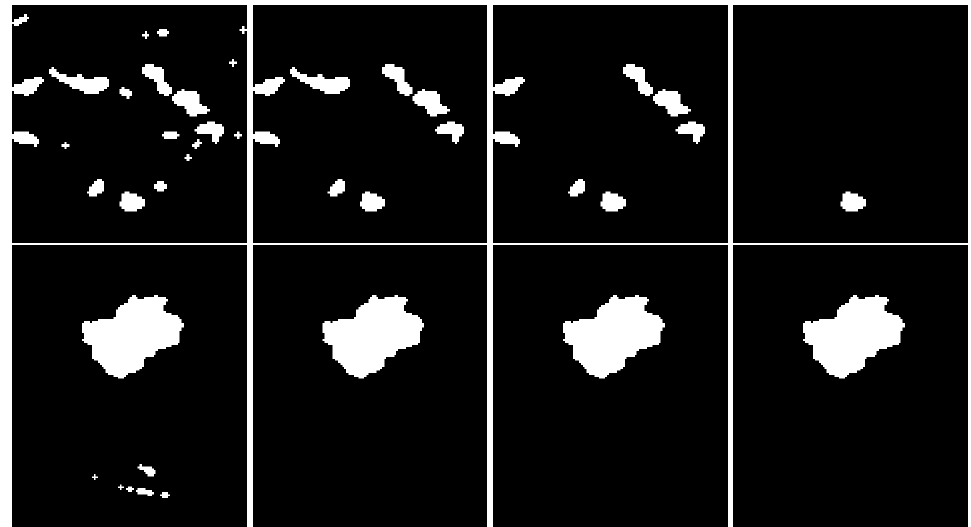
Figure 6. Examples of post-processing steps on two breast lesions (one per row): ( 1st column ) binary mask obtained after sFCM clustering; ( 2nd column ) mask after the small-area removal; ( 3rd column ) mask after both the small-area removal and the eccentricity-based selection; and ( 4th column ) mask after ratio criteria, defined in Equations (18) and (19). With respect to the position in the DCE-MRI sequence, all images have been rotated 90° clockwise, in order to improve the graphical representation and allow all the images, related to aspecific lesions, to be displayed in a single line.